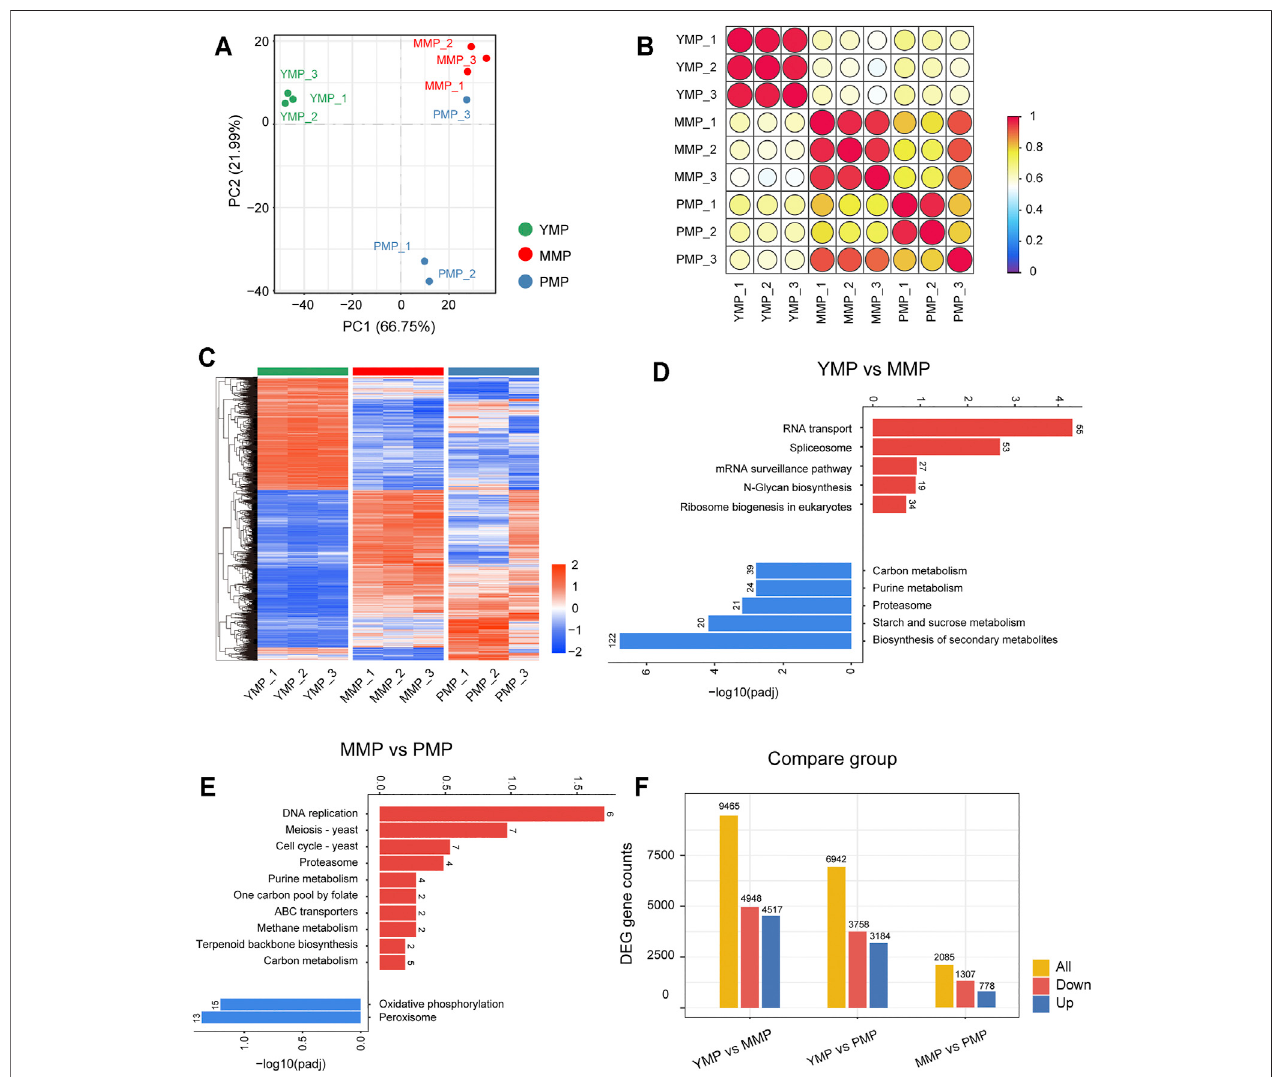
FIGURE 1 | Dynamic transcriptional changes during three growth stages of M. sextelata . (A) : PCA analysis of the samples from the three stages. (B) : The correlationheatmapofthesamplesfromthethreestages. (C) :Theheatmapshowingthedifferentiallyexpressedgenesamongthethreestages(theredandbluecolors indicate the pathways enriched by the upregulated and downregulated genes, respectively). Bar plots representing the KEGG enrichment results (the red and blue bars indicate the pathways enriched by the upregulated and downregulated genes, respectively) for (D) : YMP vs. MMP and (E) : MMP vs. PMP. (F) : The number of differentially expressed genes at the three different stages, i.e., the young mushroom period (YMP), marketable mature period (MMP), and physiological maturity period (PMP).